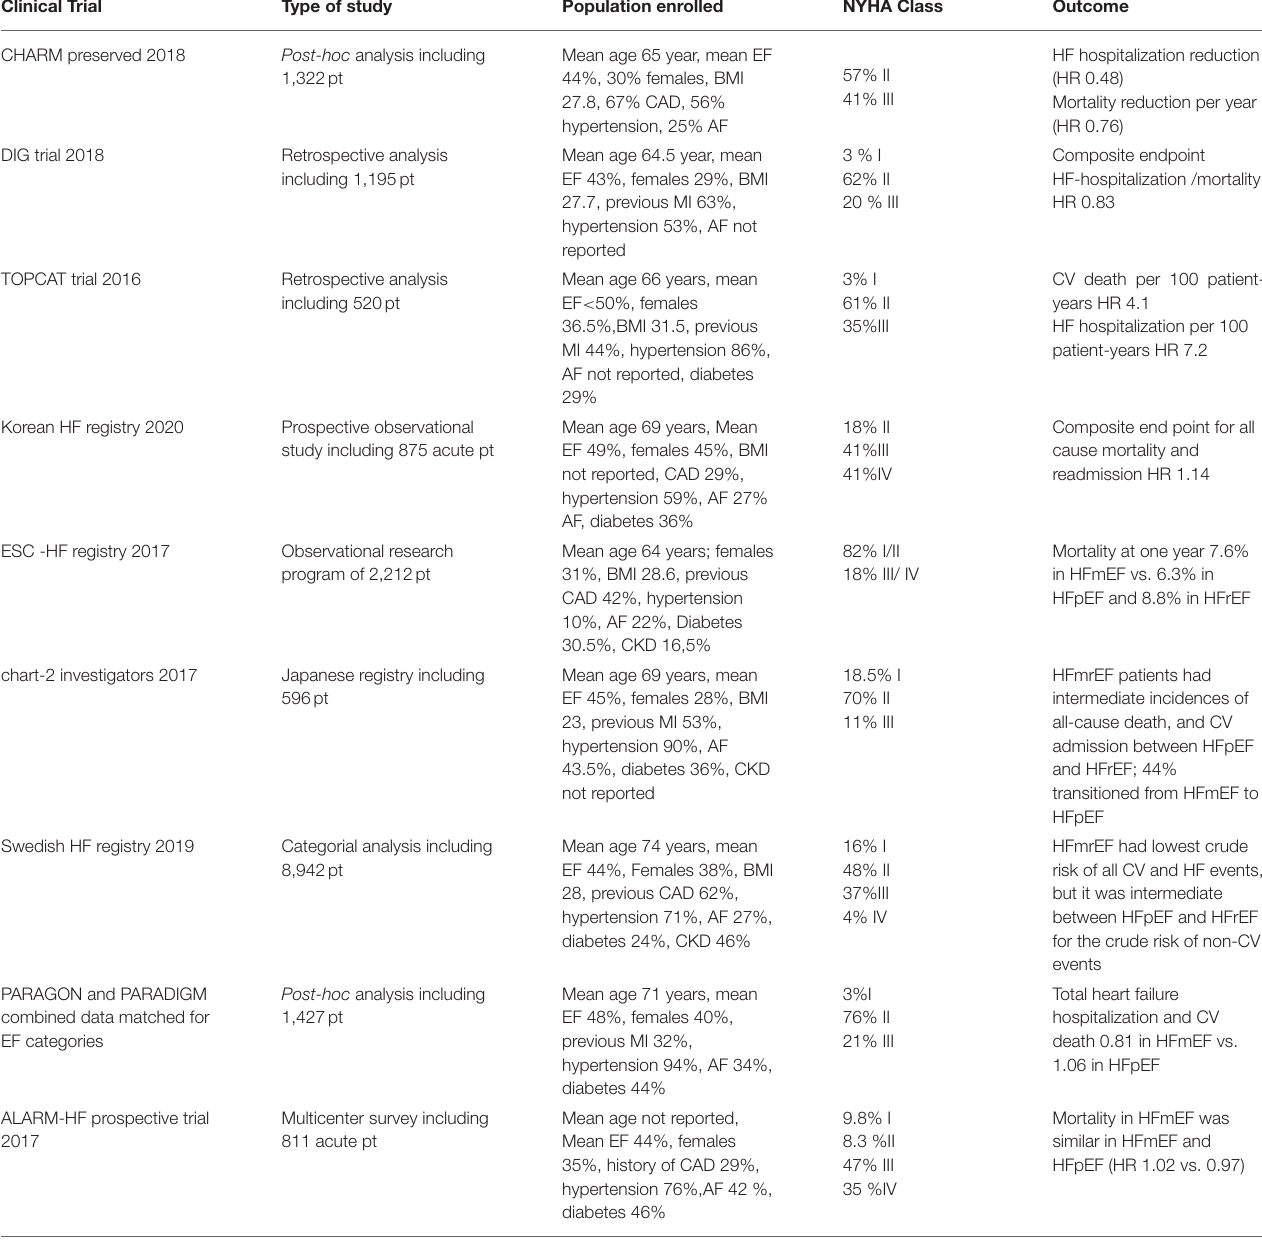
TABLE 1 | Clinical trials describing prevalent risk factors, comorbidities, and causes of